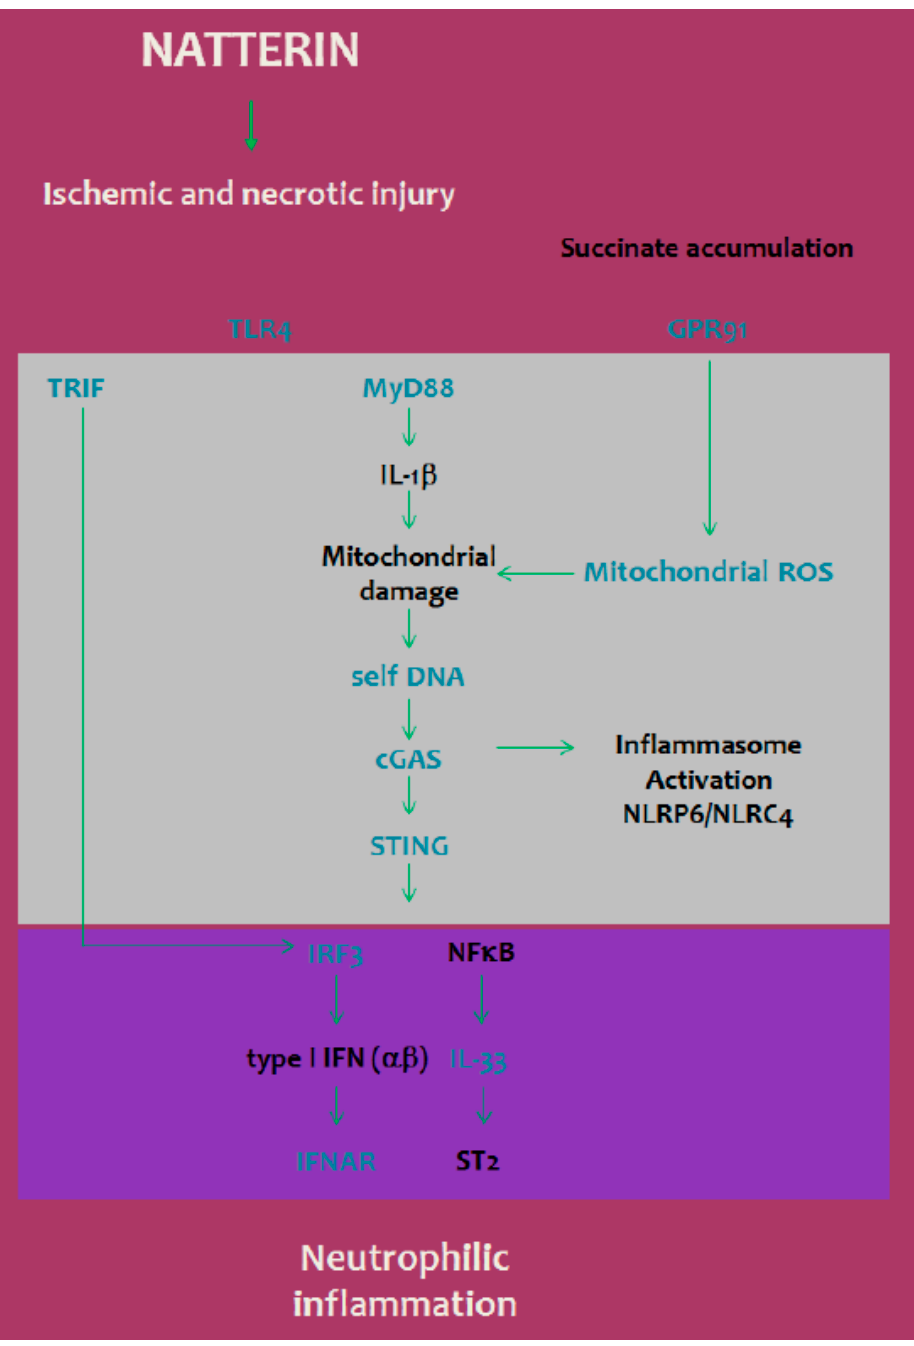
Figure 4. Neutrophilic inflammation induced by Natterin requires cGAS/STING/IRF3 via type I IFN receptor. Natterin induces neutrophilic infiltration with cell activation and release of cytosolic molecules, such as DNA, succinate and ROS. cGAS/STING drives IRF3-mediated inflammation dependent on type I IFN receptor. The activation of the STING pathway requires TLR4/TRIF- dependent pathway, essential for the production of type I IFNs, which synergizes with processed IL-33 to coordinate inflammation. Our data clarify that the neutrophilic inflammation induced by Natterin an aerolysin-like toxin is the result of activation of cytosolic DNA sensors pointing to the possibility of new pharmacological tools for its control.